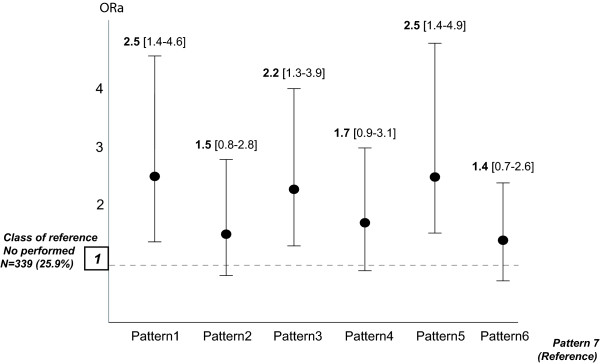
Adjustedaodds ratios (ORa) for the likelihood of walking and cycling over weekly duration categories (n = 487, 37.2%) by built environmental patternsb.aAdjusted for individual characteristics (age, education level) and socio-economic environmental characteristics (median income) bBuilt environment patterns (1 to 7) are those described on Figure 2.